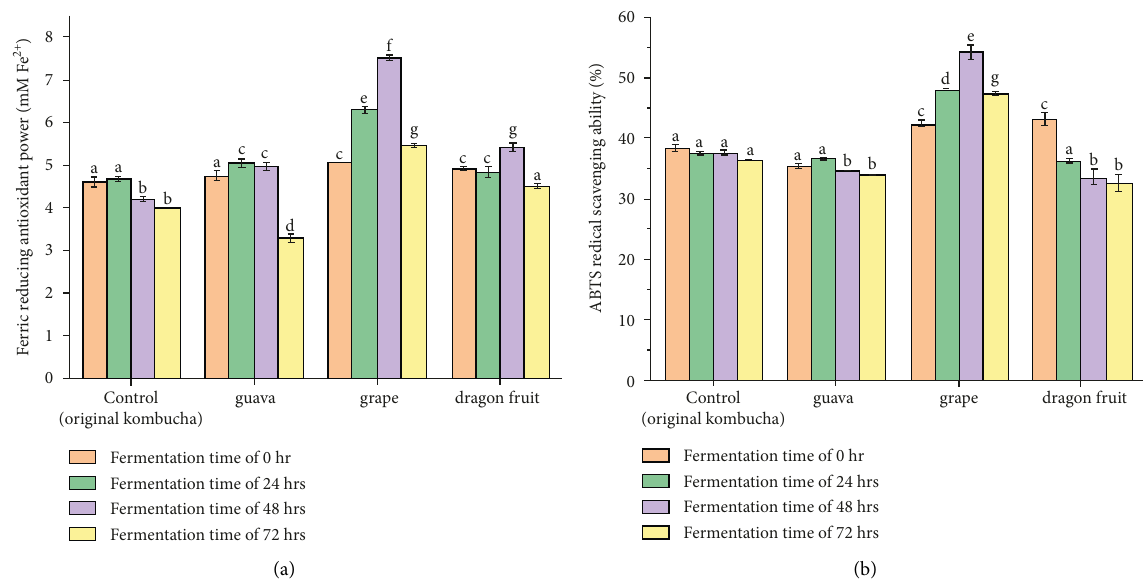
Figure 3: Antioxidative activity of original green tea kombucha and three fruit kombuchas fermented for different durations measured by ferric reducing antioxidant power (a) and ABTS radical scavenging ability (b). Different letters in the same graph indicate significant difference ( P < 0 . 05).